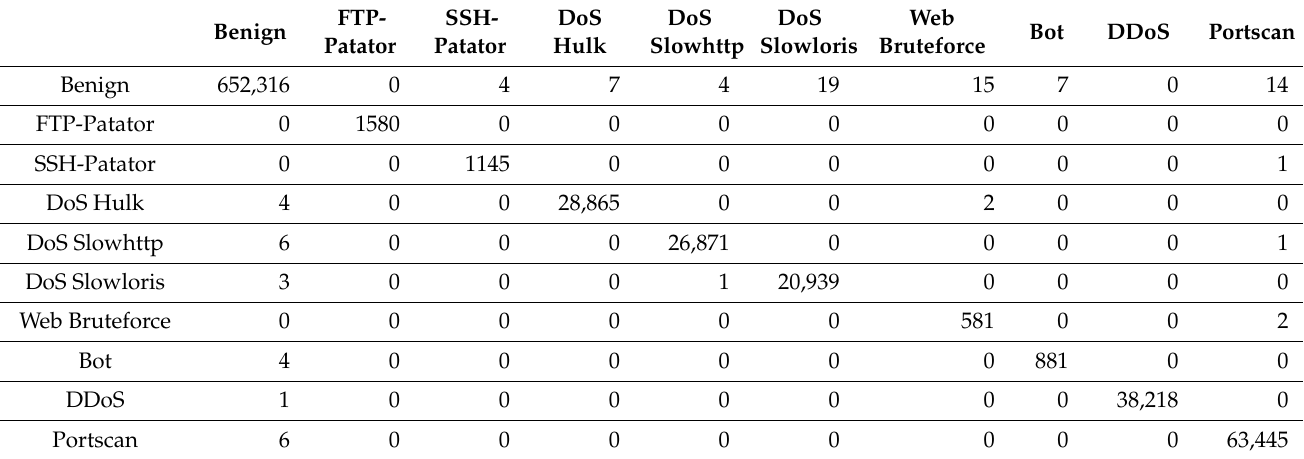
Table 10. Confusion matrix for DTKNN using the integrated